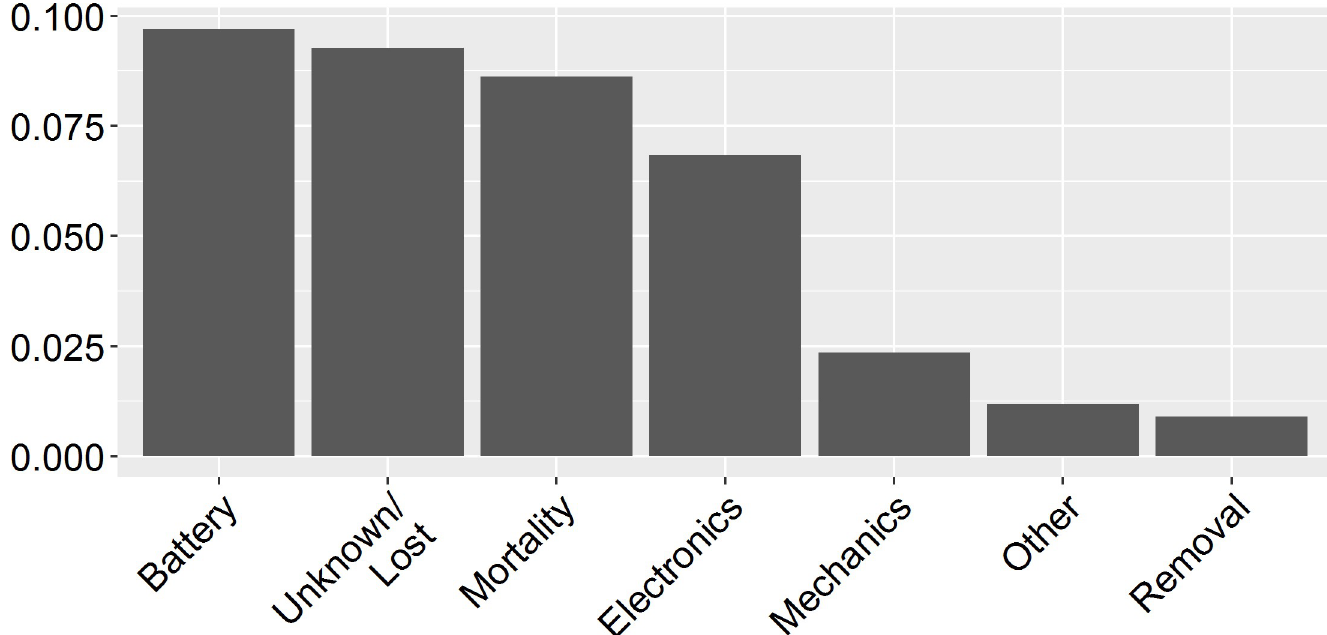
Fig 6. Causes for premature ending of deployments. Proportion of reported deployments ending prematurely due to various unit or animal-related factors.